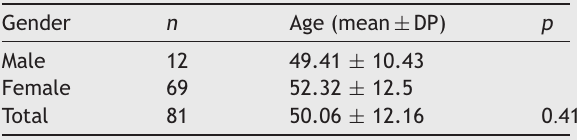
Sample characterization in relation to gender and age.